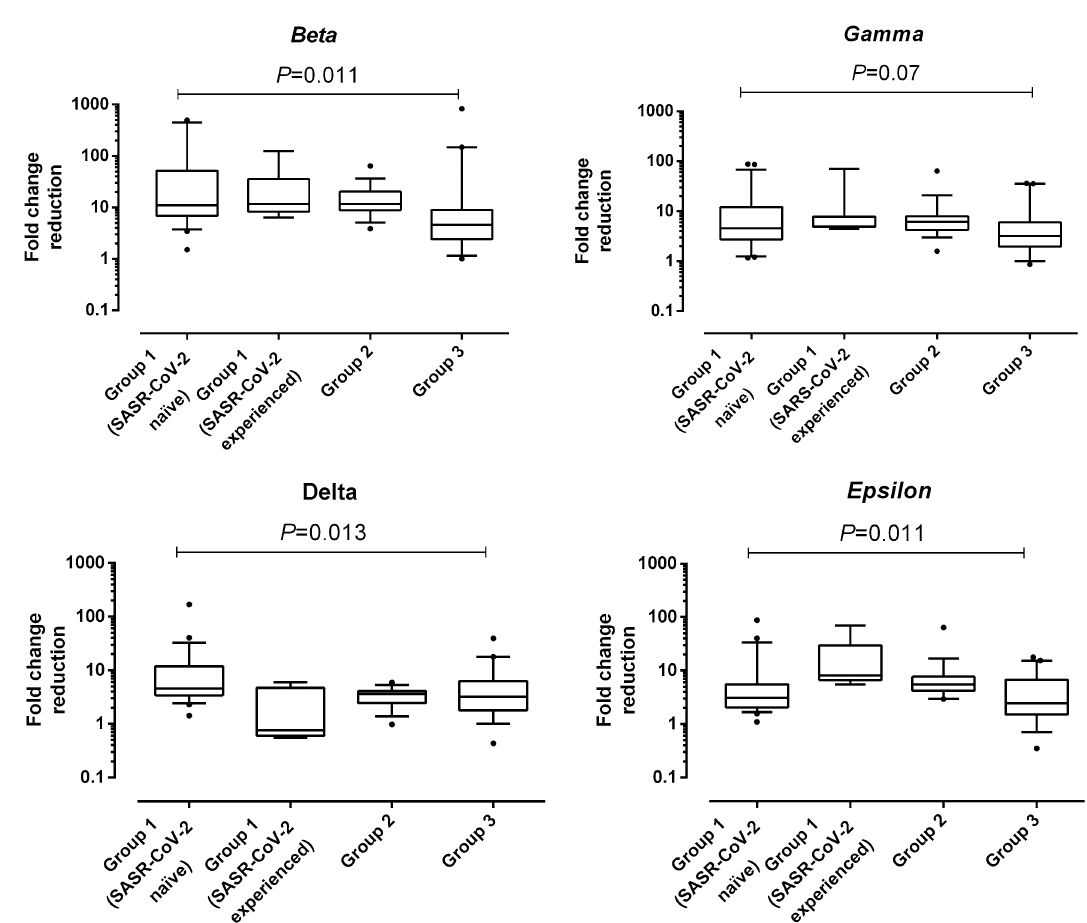
Figure 3. Box-whisker plots depicting fold change reduction in neutralizing antibody titers against SARS- CoV-2 variants of concern as compared to the ancestral strain as a function of the study group considered. P value for comparison across the three groups is